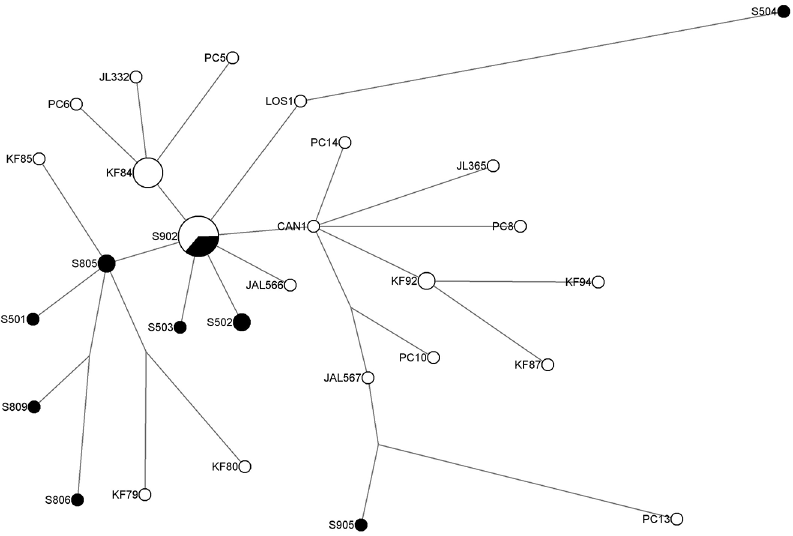
in the network span nucleotide positions 15561 –